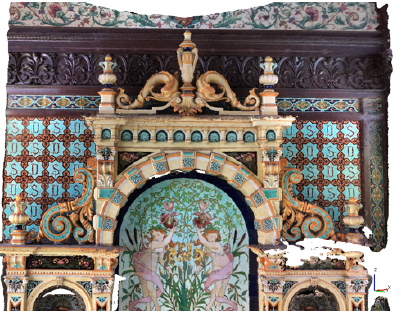
Figure 4. Textured model of the upper part of the fountain (extracted from a video)